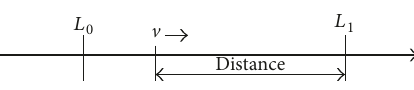
Figure 1: Time step calculation for a variable.